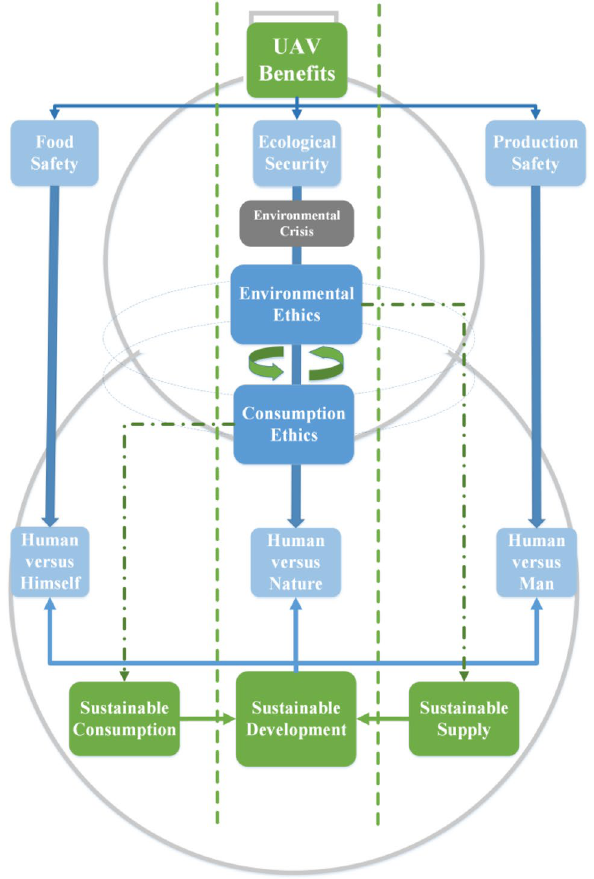
Figure 1. Model of environmental consumption